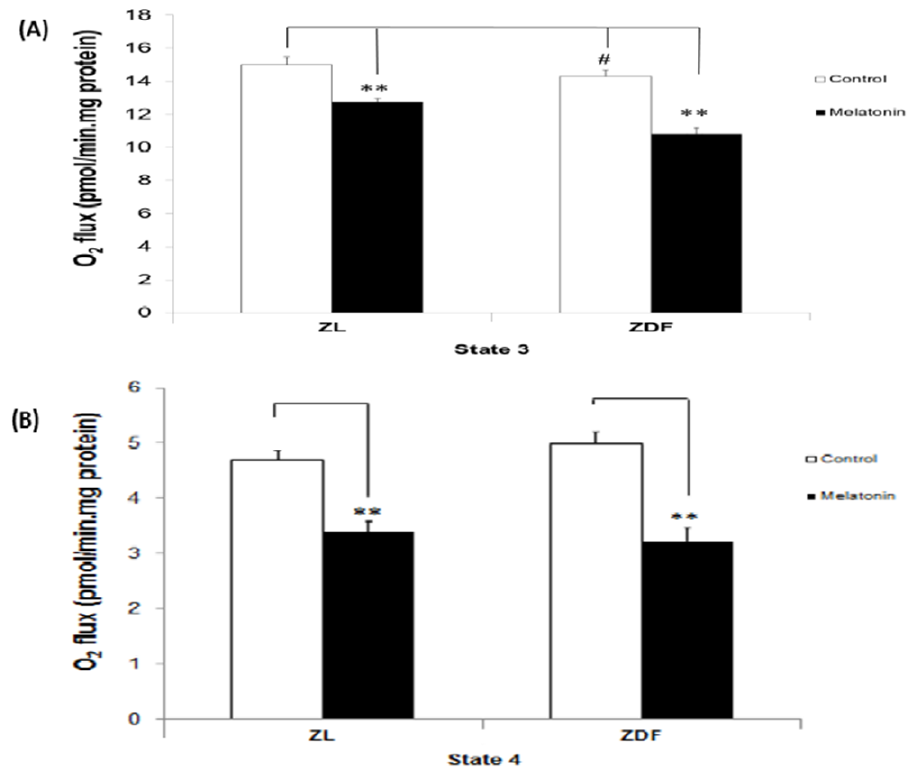
Figure 1. The effect of melatonin treatment on respiratory states in isolated mitochondria from brown fat depots of control (untreated) and melatonin-treated ZDF and ZL rats. ( A ) The upper panel shows state 3, representing oxygen flux, while producing ATP in response to ADP pulses in the presence of substrates. ( B ) The lower panel illustrates state 4, or leak respiration, which shows oxygen flux in the absence of ATP synthesis. Glutamate/malate was used as the respiratory substrates. C, control; M, melatonin; ZL, Zücker lean rats; ZDF, Zücker diabetic fatty rats. Values are shown as mean ± SD. Superscript characters show significant differences determined by two-way analysis of variance (ANOVA) followed by the Tukey post hoc test ( ** p < 0.01, M-ZDF compared with C-ZDF rats; # p < 0.05, C-ZDF compared with C-ZL rats).